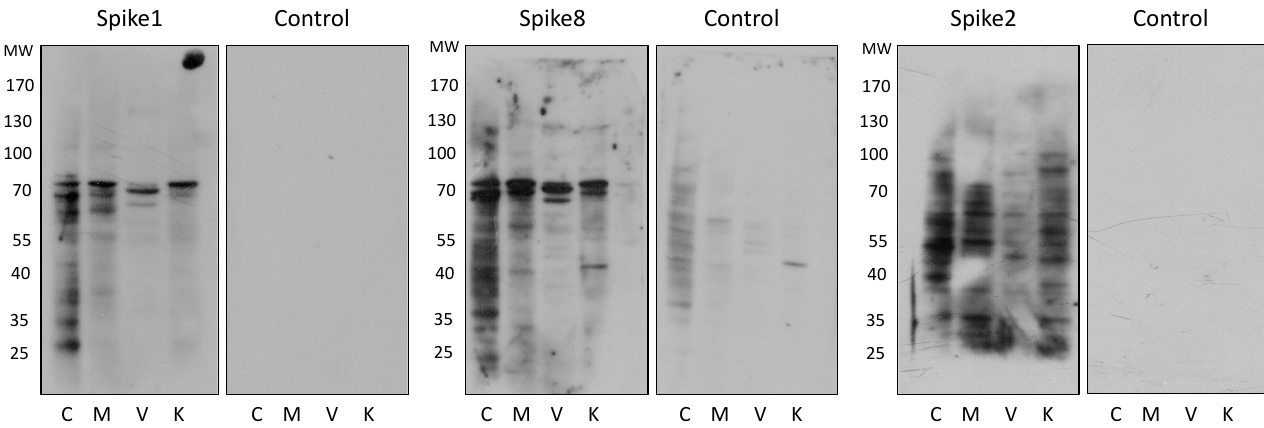
Figure 2. Potential cellular interactors for HAstV spike proteins identified by far-Western blotting. Cell membrane-enriched protein extracts from the indicated cell lines were separated by SDS-PAGE and transferred to nitrocellulose membranes that were incubated overnight with the recombinant spike proteins corresponding to HAstV-1, -2 or -8, and the spike proteins Fig. 3 were detected with serotype-specific anti-spike antibodies. As a control, membranes were incubated without the spike and were developed with the antibodies against the respective spike. A representative image from at least three independent experiments is shown. C, Caco-2; M, MA104; V, Vero; K, MDCKII cells.